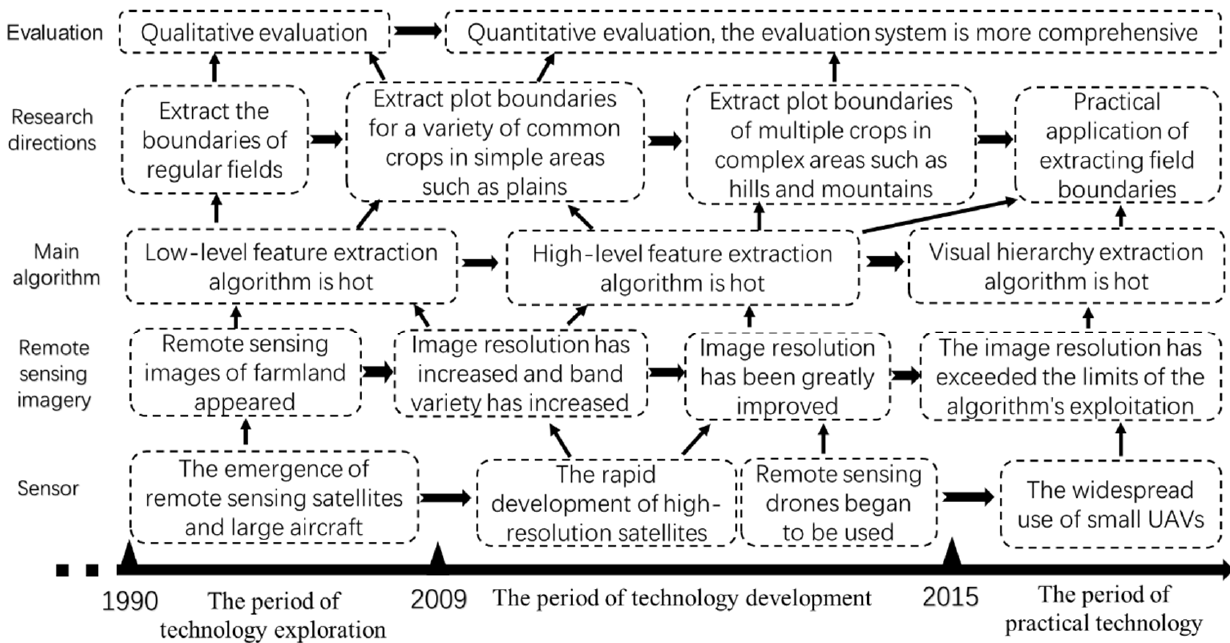
Figure 8. The development process of farmland boundary extraction technology.